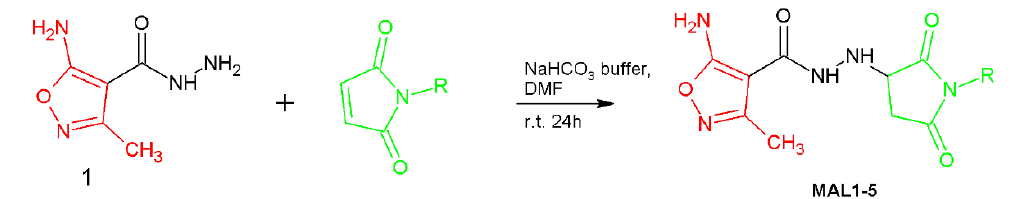
Figure 2. Synthesis of isoxazole linked maleimide conjugates ( MAL1-5 ).